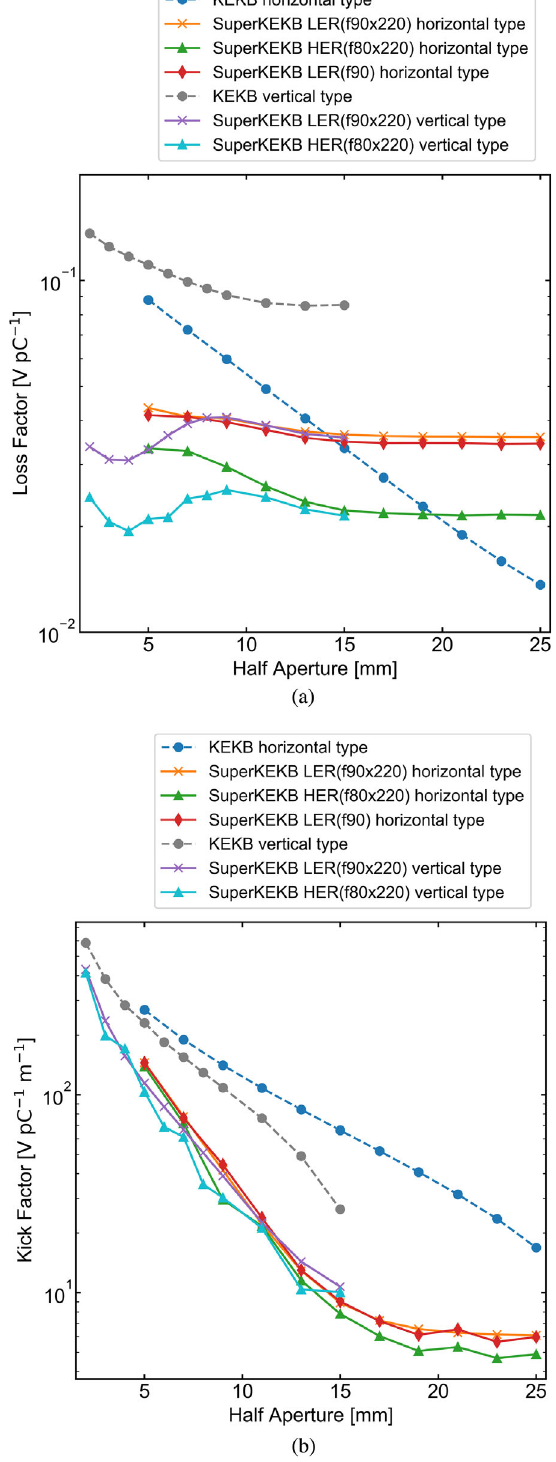
FIG. 8. (a) Loss and (b) kick factors for collimators as a function of the half apertures calculated with GDFIDL . The bunch length is 6 mm. The kick factors are calculated with a beam offset of 1 mm from the center in the horizontal direction for the horizontal collimators or 0.5 mm in the vertical direction for the vertical